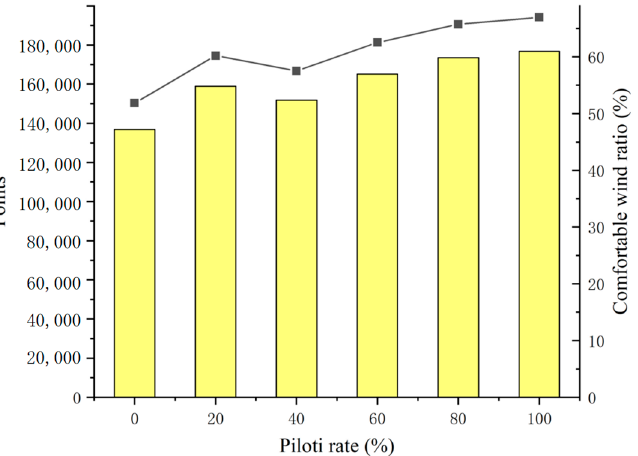
Figure 16. The changing pattern of a comfortable wind ratio under different piloti rates (Point model).